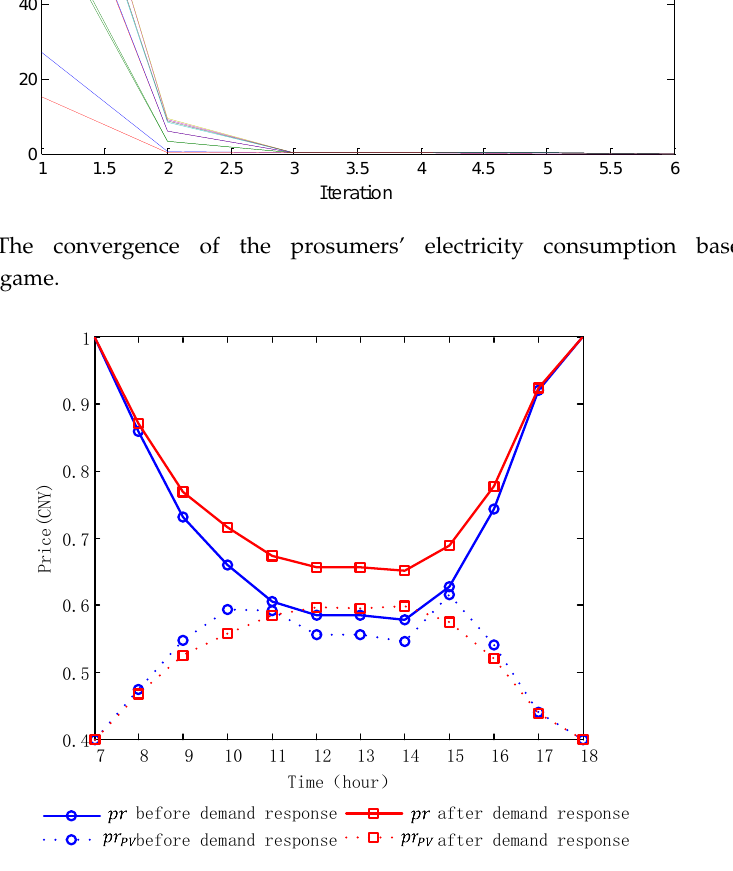
Figure 12. The comparison of prosumers’ utilities before and after DR. In Figure 11, the results show that the internal prices are increased with the DR of prosumers, due to the incentive of cheap PV energy supply. As the PV energy is constant, the DSR is increased with the total power consumption of prosumers. Thus, the internal buying price will be increased accordingly. Moreover, for the PVCO, the internal selling prices would be maximized when the DSR is getting close to 1. Thus, when in time periods 7–10 and 15–18 (DSR > 1), the internal selling price goes down with the increased DSR. In contrast, in time periods 12–14 (DSR < 1), the internal selling price rises with the increased DSR. In order to analyze the change of utilities after the prosumers participate in DR, difference values of prosumers’ utilities in each time period are shown in Figure 12. The results show that the utilities of prosumers have been reduced in time periods 7–10 and 15–18 (DSR > 1), whereas they increased in time periods 12–14 (DSR < 1). This is an interesting result, and the reason is that when DSR > 1, the non-cooperative game will push prosumers to consume more energy, and thus increase the internal buying price. Although more power consumption can accordingly increase the utilities of prosumers, the increment of internal buying price has a greater negative influence on their integral utilities. Moreover, in time periods 12–14 (DSR < 1), even though the internal buying price has been increased with the power consumptions of prosumers, their utilities still can be increased with more consumptions in general.